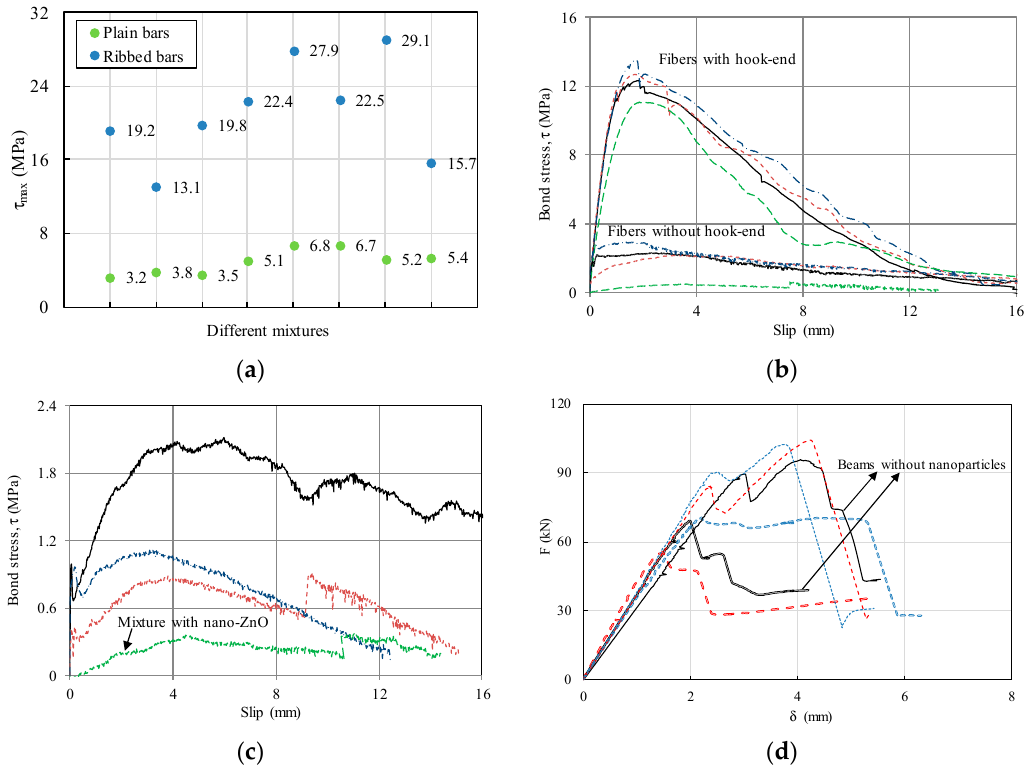
Figure 8. ( a ) Maximum bond stress on fibres; ( b ) Bond-slip curves of the fibres with and without the hook-end; ( c ) Bond-slip curves of the fibres without the hook-end anchorage and with the nanoparticles added to the binding paste; ( d ) Load-displacement curves of beams.